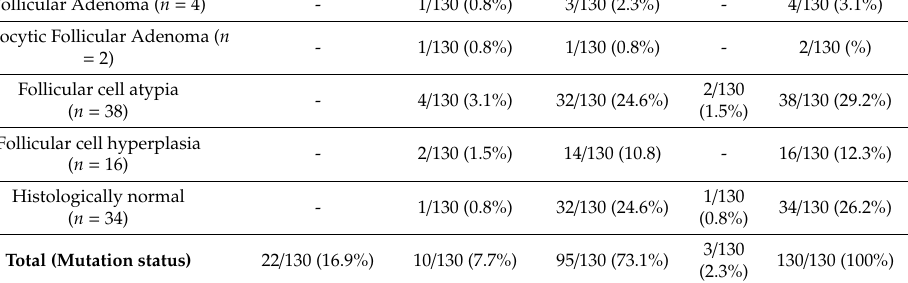
BRAF non BRAF p.V600E BRAF WT NA p.V600E